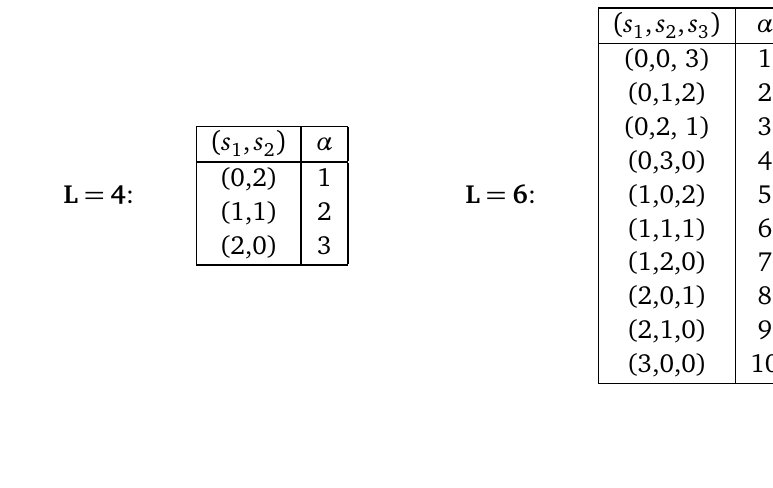
Table 1: Relationship between the subspace index α we adopt in Figure 4 and the momentum tuples ( s , s ,...., s ) which define the symmetry subspaces in the lossy L / 2 1 2 bosonic chain. Left table is for L = 4 and right is for L =